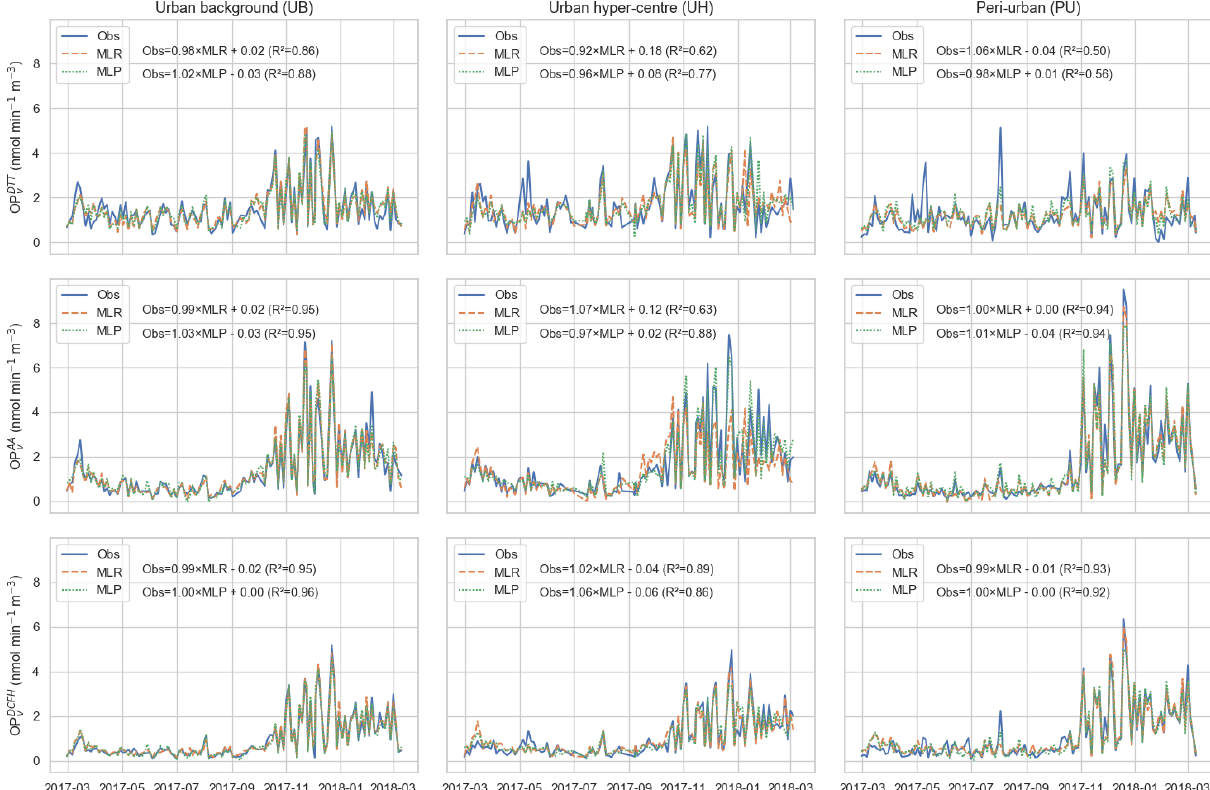
Figure 4. Comparison of the observed and modelled OP v (OP DTT v , OP AA v , and OP DCFH v ) at different urban sites using MLR and MLP models. The equation of the line and goodness of fit ( R 2 ) between observed and modelled OP are included.